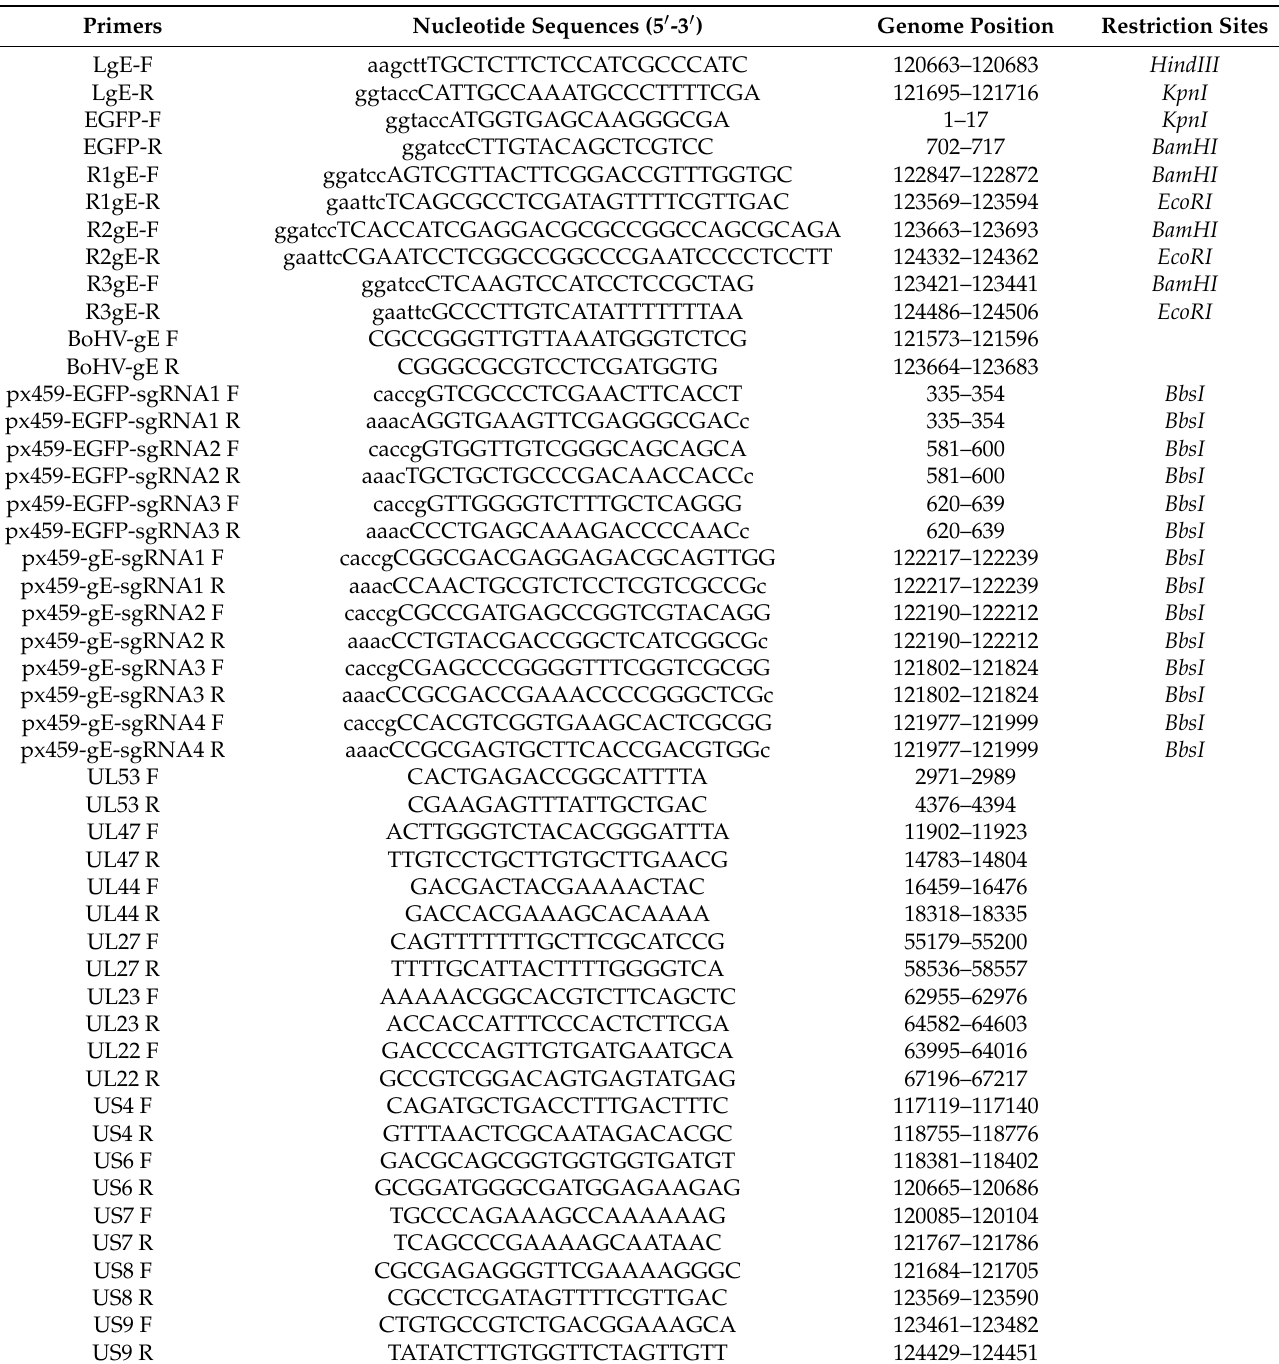
Table 1. Sequences and positions of the primers and sgRNAs utilized in this